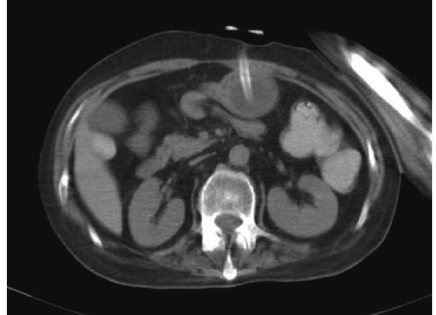
Figure 3: Replaced PEG catheter in the stomach and resolved